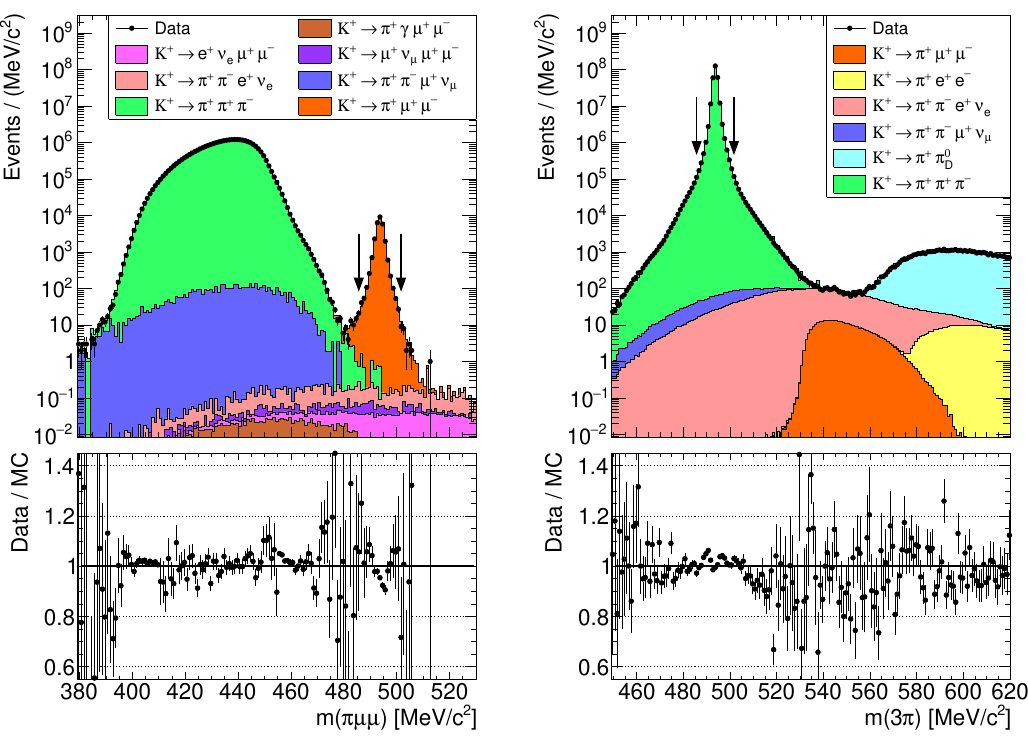
Figure 2 . Top: reconstructed mass distributions of events satisfying the signal (left) and normal- ization (right) selections. The arrows indicate the selected mass regions. The contribution from the simulated K decays is scaled according to the PDG branching fraction [22]. Bottom: ratios of πµµ data and simulated spectra for signal (left) and normalization